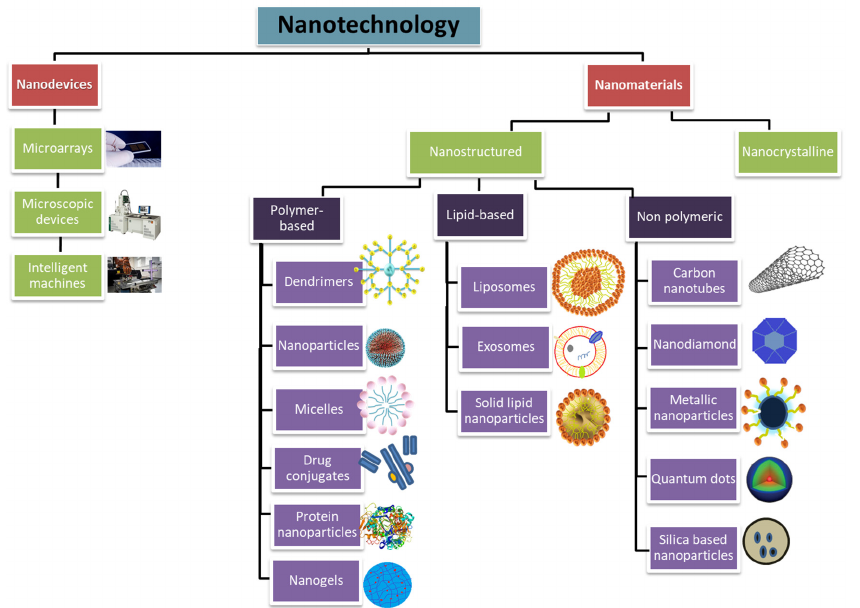
Figure 1. Elements of nanotechnology, which are utilized in therapeutic applications.